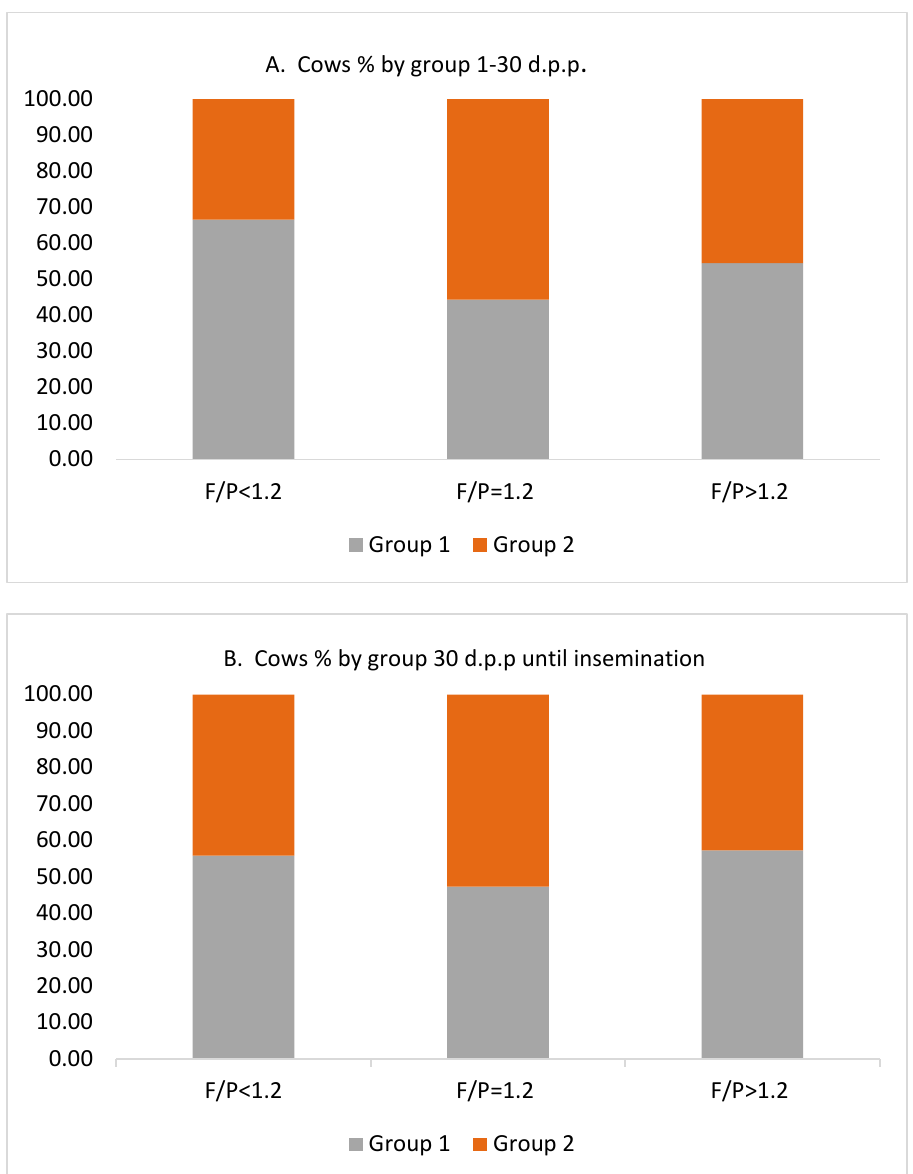
Figure 4. Relationship of milk fat to protein ratio with milk lactose level. ( A ). 1–30.p.p., ( B ). From 30 d.p.p. until insemination. Group 1—milk lactose < 4.70%, Group 2—milk lactose ≥ 4.70%. F/P—milk fat/protein ratio.